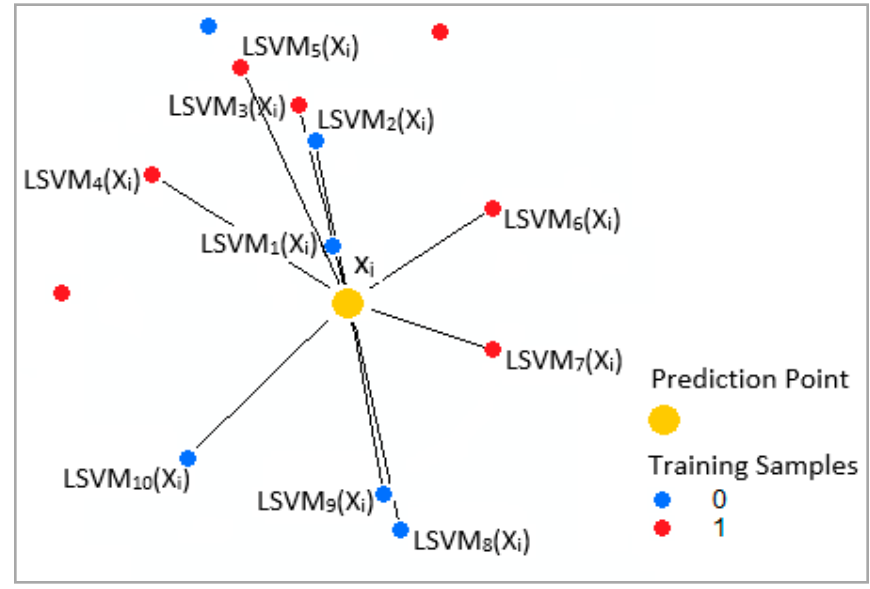
Figure 6. Calculation of the urban development probability at prediction point i using the neighbour-calibrated LSVM models.